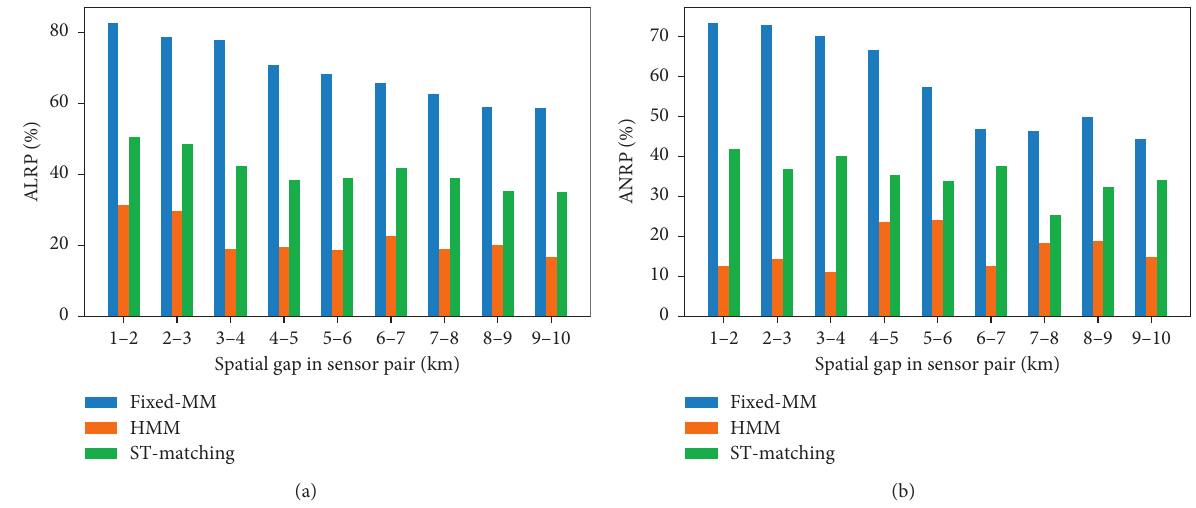
Figure 11: (a) ALRP and (b) ANRP with respect to the spatial gap.